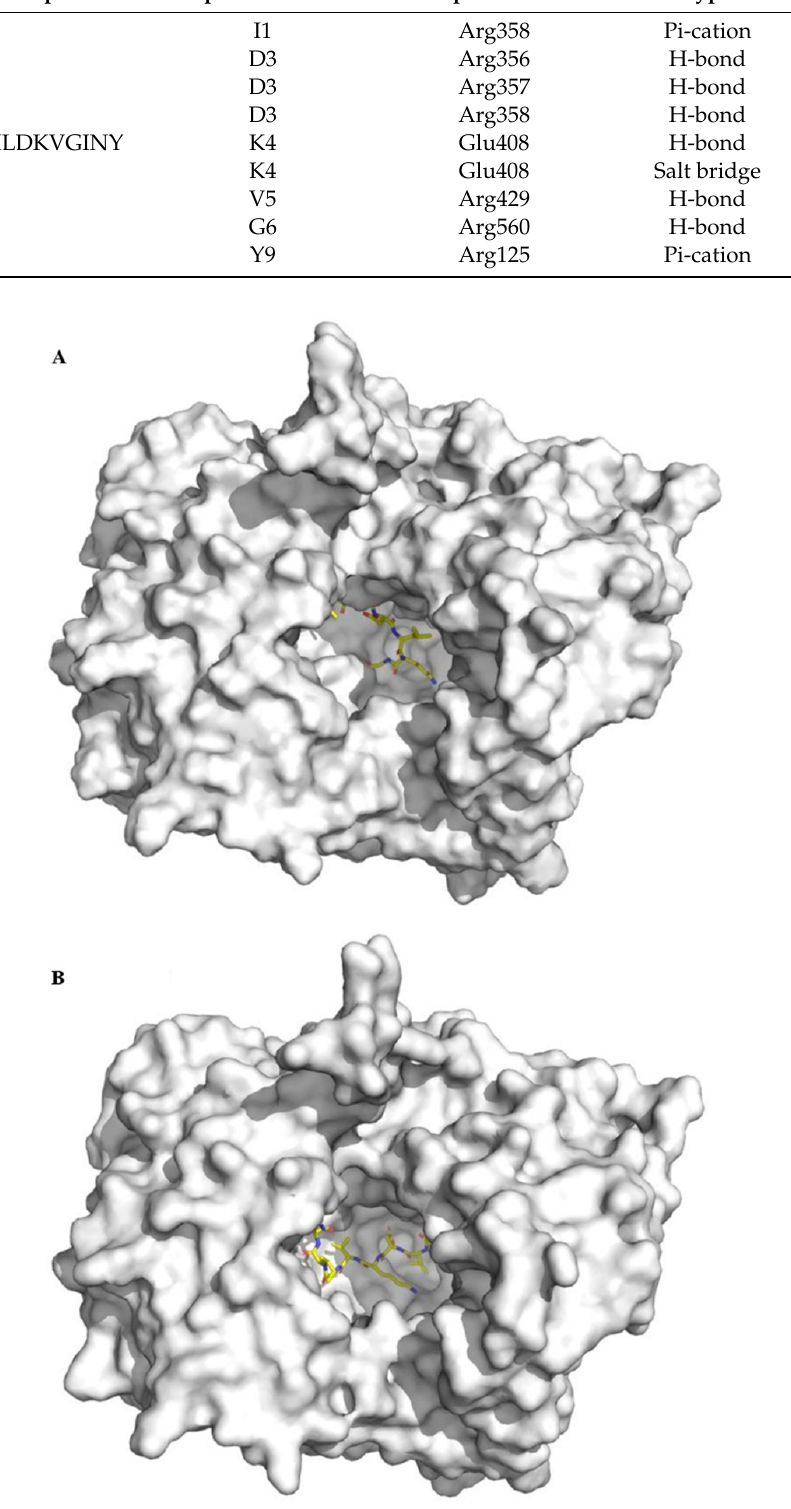
Figure6. 3DbindingmodelofELKDLKGY( A )andILDKVGINY( B )withthetargetDPP-IV.Thereceptor Figure 6. 3D binding model of ELKDLKGY ( A ) and ILDKVGINY ( B ) with the target DPP-IV. The (DPP-IV) is depicted as white and the ligand (peptide) is depicted as receptor (DPP-IV) is depicted as white and the ligand (peptide) is depicted as yellow.